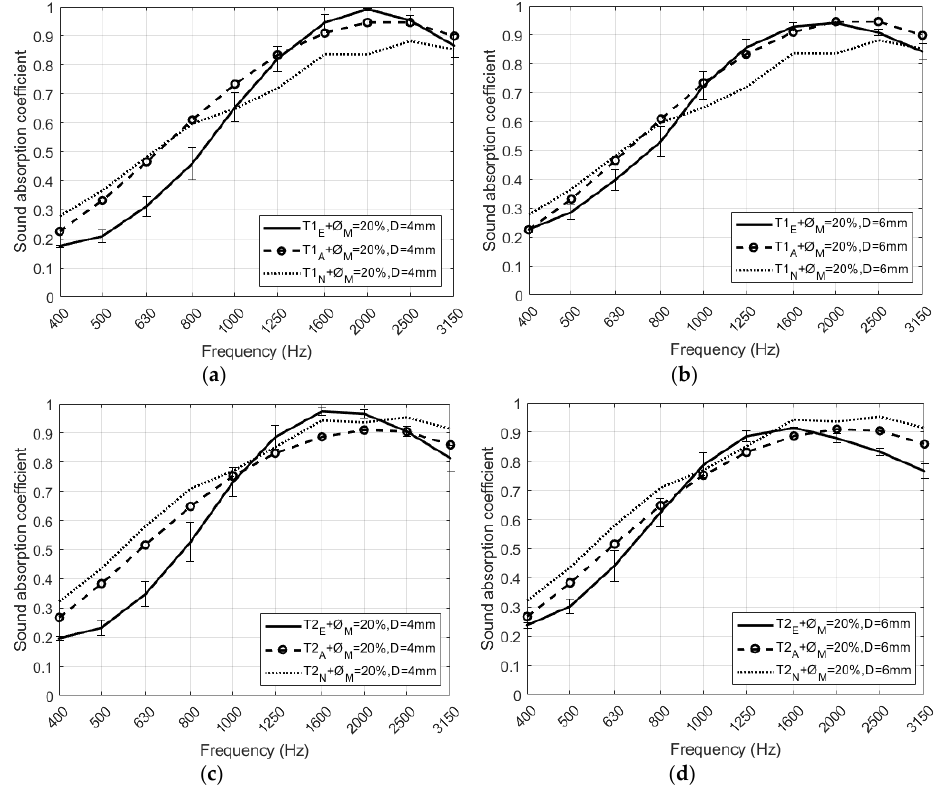
Figure 14. Normal incidence plane wave sound absorption coefficient of the RPU samples covered with two different textile fabrics. Comparison between measurement ( continuous lines ) theoretical model ( dashed lines ) and numerical model (dotted lines) of ( a ) T1 fabric with 20% and D = 4 mm, ( b ) T1 fabric with 20% and D = 6 mm, ( c ) T2 fabric with 20% and D = 4 mm, ( d ) T2 fabric with 20% and D = 6 mm.